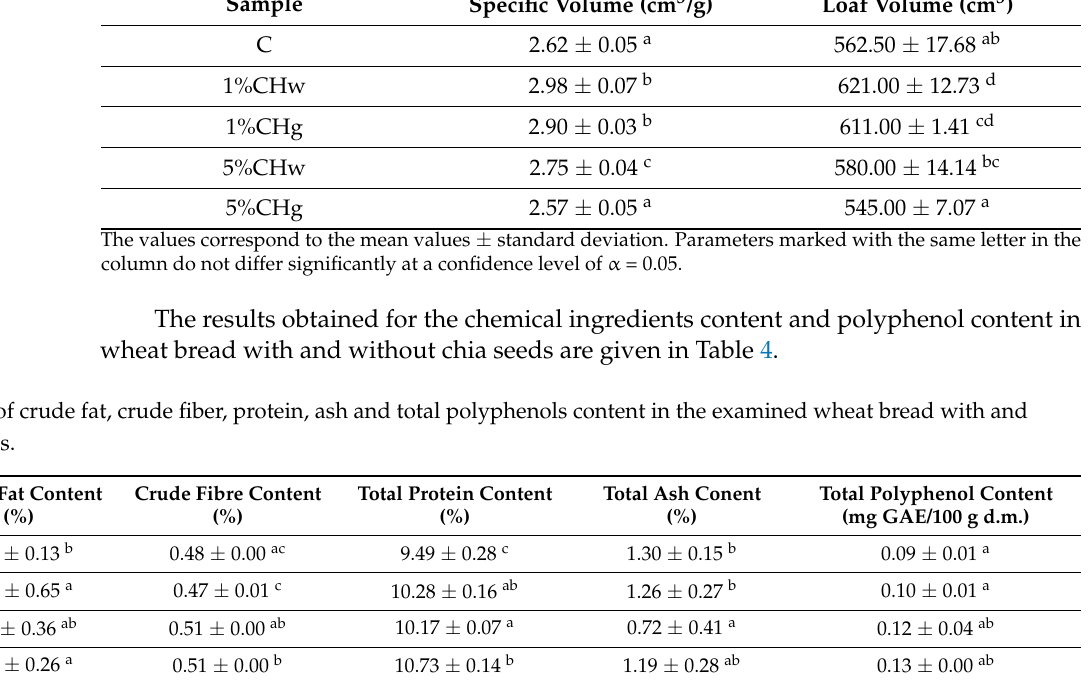
Table 3. Specific volume and loaf volume of wheat bread with and without chia seeds. Sample